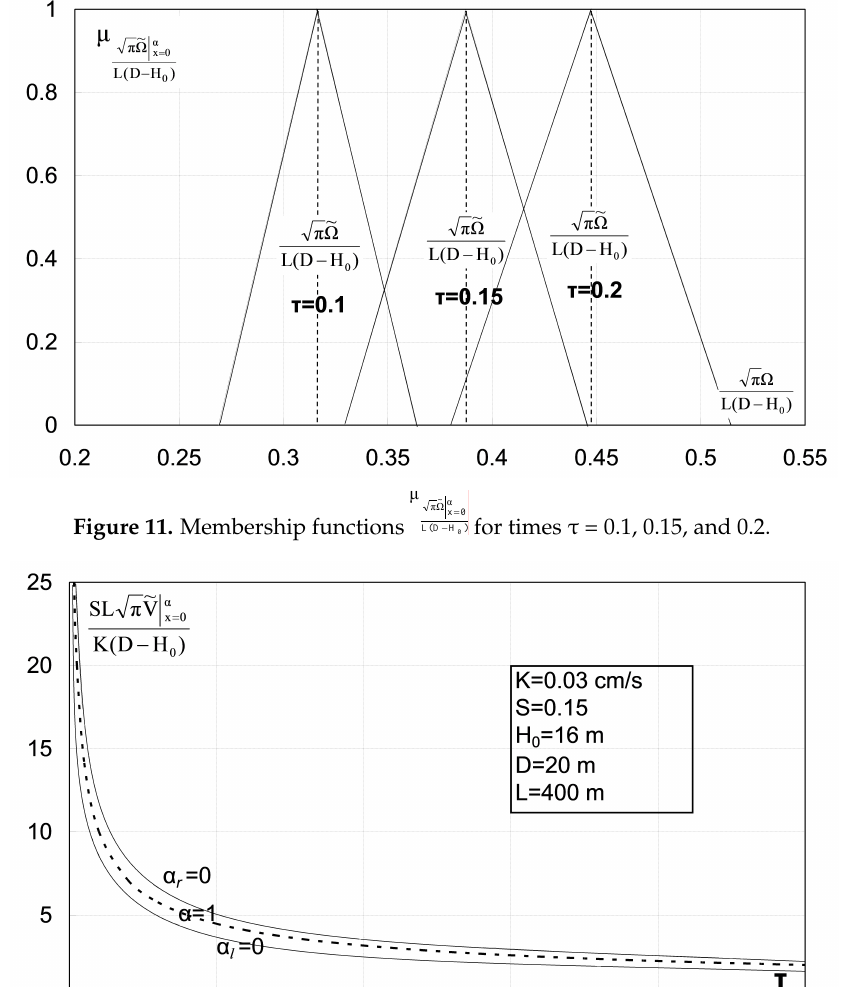
τ . Figure 12. The real dimensionless velocity